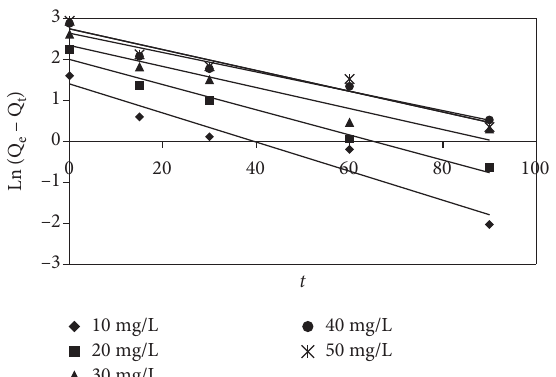
Figure 11: Linearity of the pseudo-first-order model.